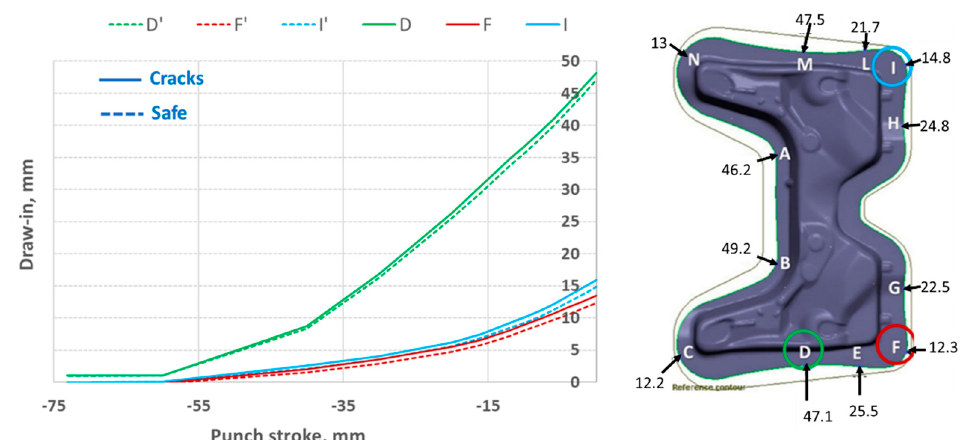
Figure 15. Draw-in as a function of the punch stroke at Points D, F and I of the sheet in the optimized condition (safe) and in the non-optimal condition (cracks).